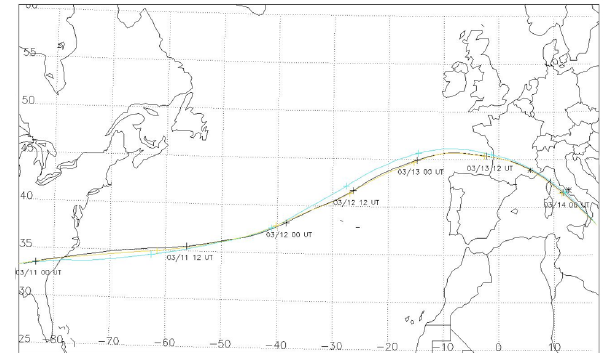
Fig. 3. Backward trajectories initialized 14 March 2008 at 01:00UTC until 11 March 2008 at 01:00UTC for three atmo- spheric levels (10.7, 11.2, 11.7km; black, yellow and blue, respec- tively) that include bottom and top heights of the cirrus observed by OHP and RTV lidars. Stars points denote the positions of OHP (43.9 ◦ N/5.7 ◦ E) and RTV (41.8 ◦ N/12.7 ◦ E) sites, while plus points indicate the air mass temporal position every